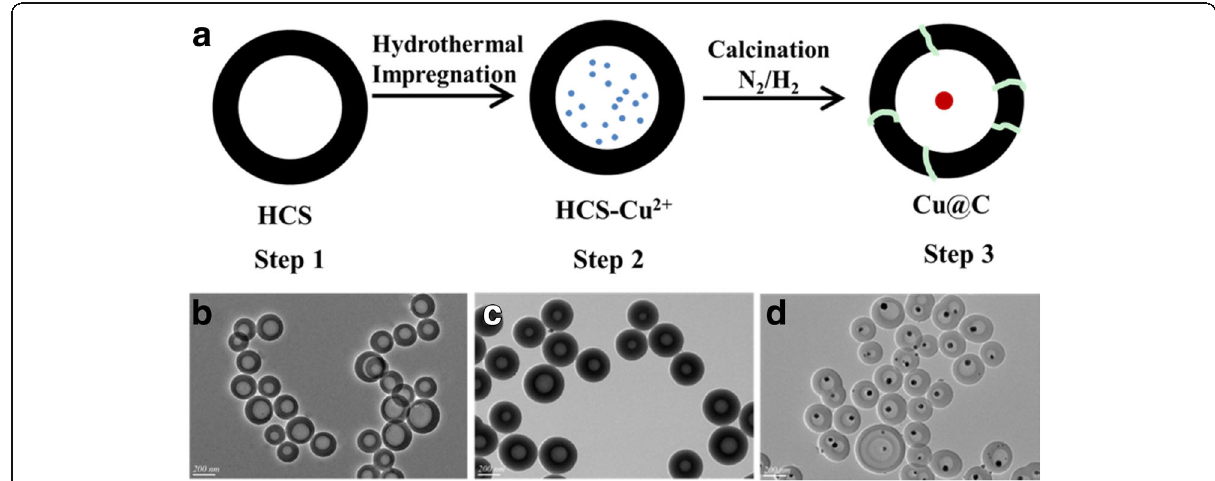
Fig. 2 a Schematic illustration for the synthesis of Cu@C nanocomposites under hydrothermal impregnation condition. TEM images of the products obtained after each step: b HCS, c HCS-Cu 2+ , and d